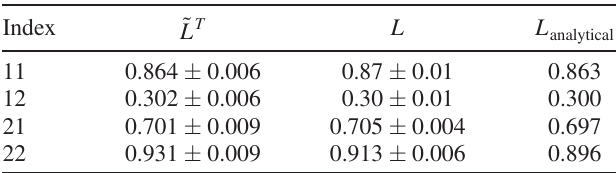
TABLE I. Experimentally determined Onsager coefficients for forward and reversed protocols, with theoretical predictions. The superscript T denotes the transpose of the